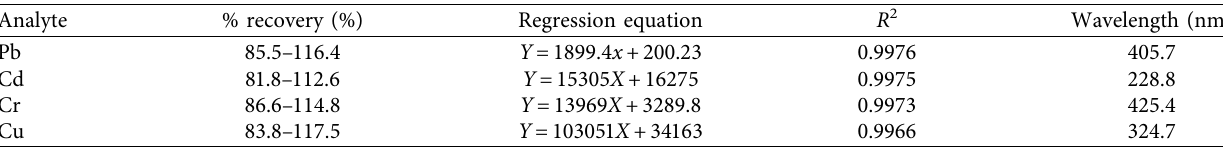
Table 2: Recovery test results and calibration curve equations ( Y � mx + b ) ∗ for the determination of heavy metals in herbal preparations. Analyte % recovery (%) Regression